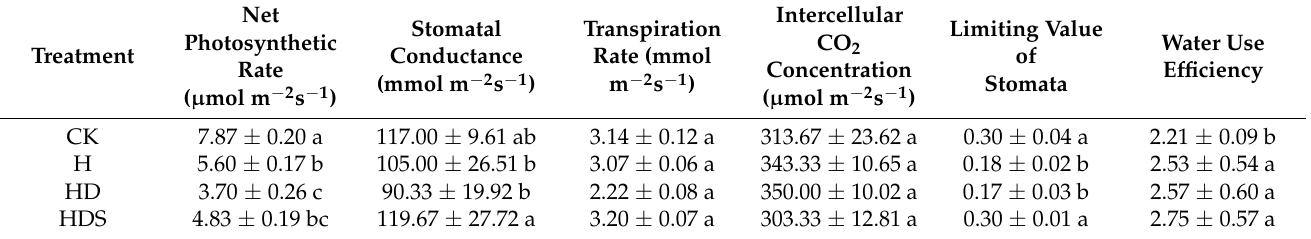
Table 2. Effects of exogenous spermidine and D-arg on the photosynthetic parameters of lettuce under high-temperature stress.